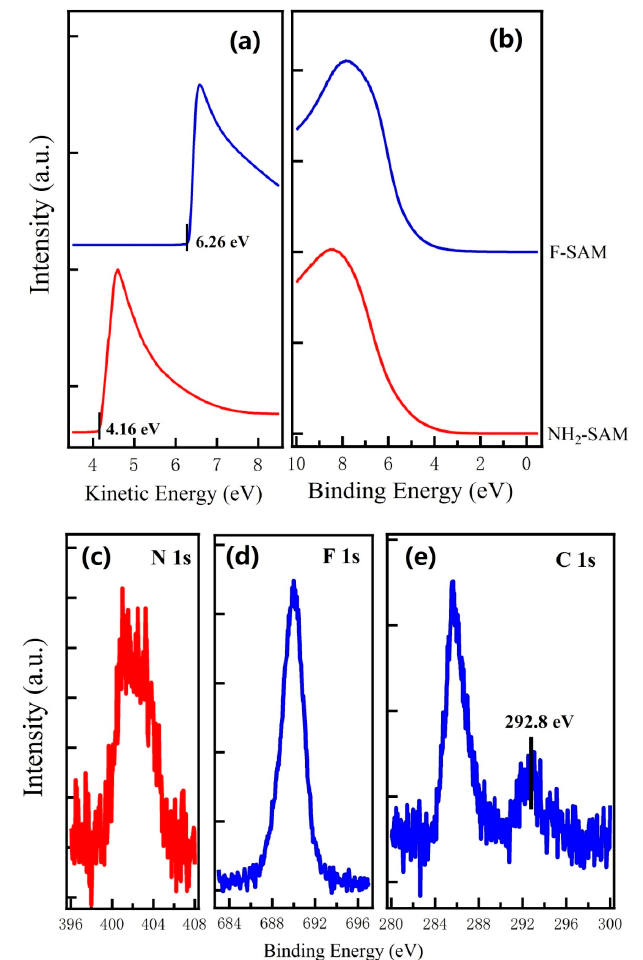
Figure 1. UPS spectra at the ( a ) low kinetic energy region and ( b ) low binding energy region for NH 2 -SAM and F-SAM on SiO 2 substrates, respectively; XPS spectra of ( c ) N 1s for NH 2 -SAM, and ( d ) F 1s and ( e ) C 1s for F-SAM.